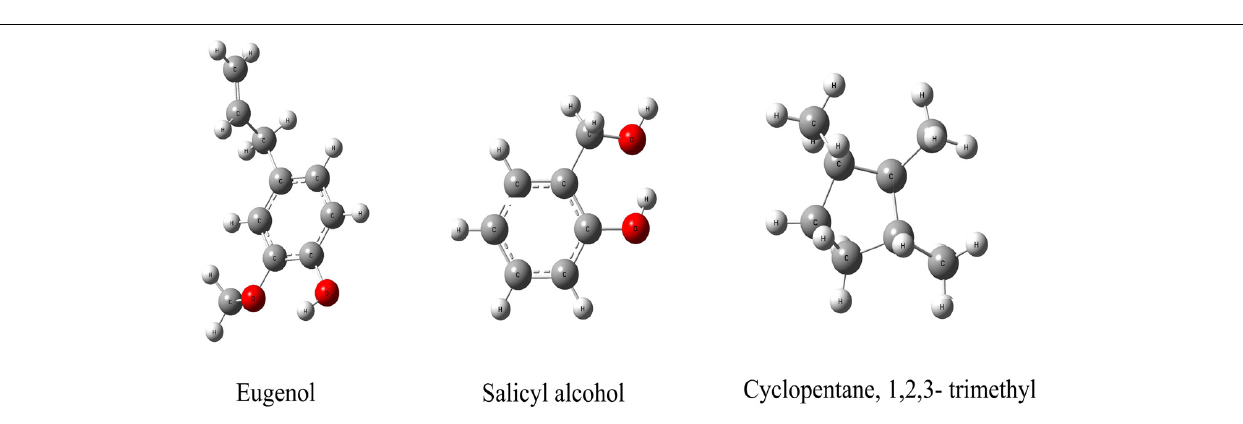
( Figure 5 ) acted as ligands for target proteins ( Figure 6